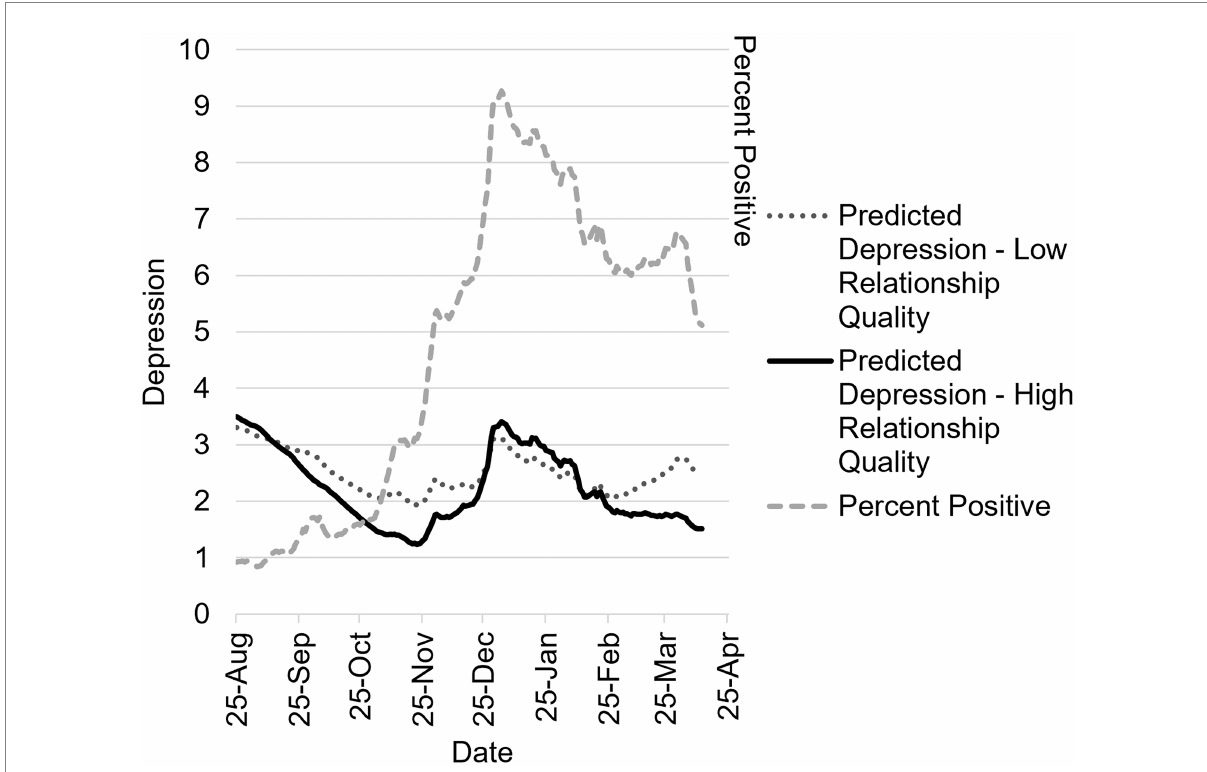
FIGURE 4 Three-way interaction model predicting daily depression between August 2020–April 2021 as a function of COVID-19 percent positivity testing rate, season, and relationship quality. Predicted daily depression in individuals with low-quality ( − 1 SD ) and high-quality (45; maximum score, since +1 SD was slightly outside the range of the scale) relationships as a function of daily percent positive testing rate in NYC and season. Depression scores can range from 1 to 9, and percent positive can range from 0 to 100, but the range of percent positive was 0.84 to 9.14 during the observation period. The jagged shape of the graph comes from modeling the effect of actual reported citywide seven-day percent positivity